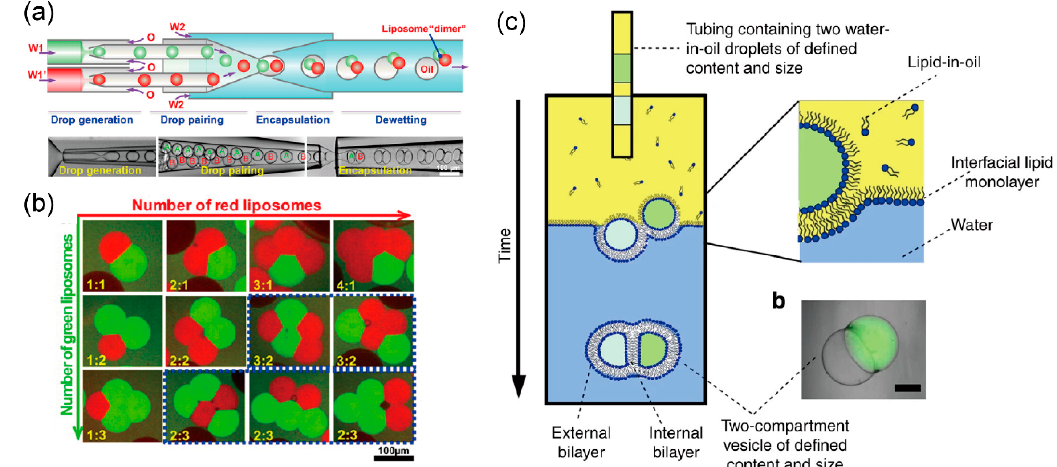
Figure 4. ( a ) Formation of double emulsions with two distinct drops into the microfluidic device; ( b ) control of the structure and the number of compartments of cell-sized lipid vesicles. (( a , b ) are reproduced with permission from [103].). ( c ) Multicompartment giant lipid vesicles formed by expelling the w / o droplets from the capillary; reproduced with permission from